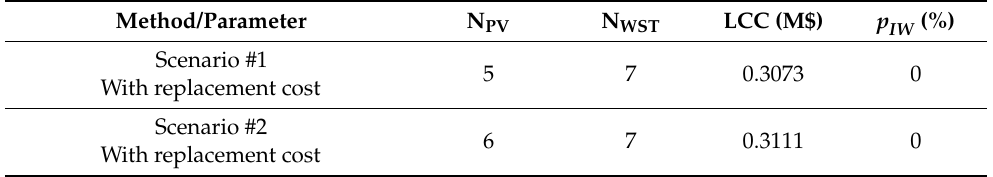
Table 16. Results of effect of considering replacement cost for Scenarios 1 and 2.